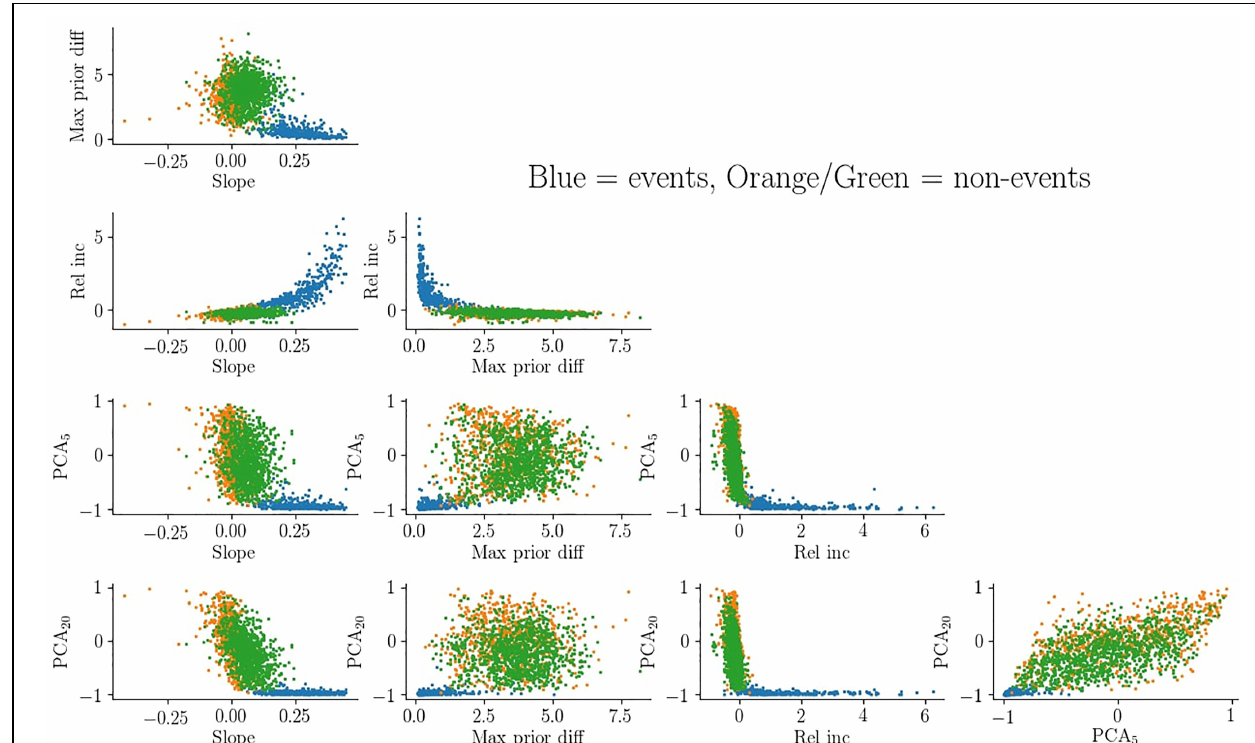
FIGURE 2 | Distribution of events and non-events with respect to the features described in Section 3.1.2 . The blue dots illustrate events while the orange and green dots are non-events . Data in non-events associated with more quiet conditions are orange while the ones associated with more active conditions are green.